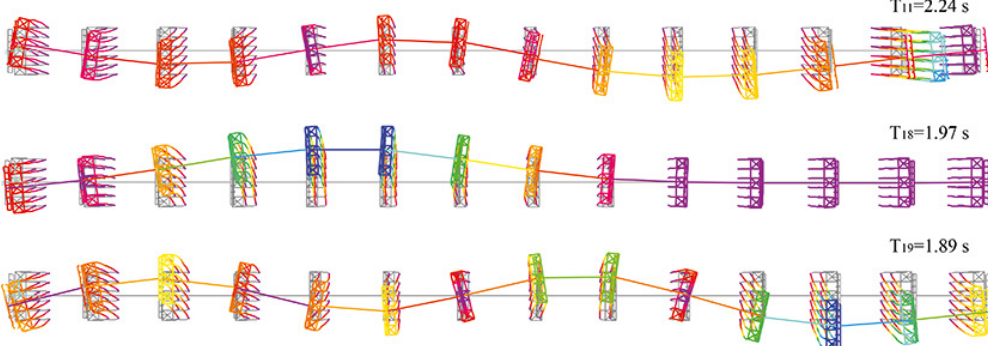
Figure 4. Modal properties with the maximum mass participation (top view)